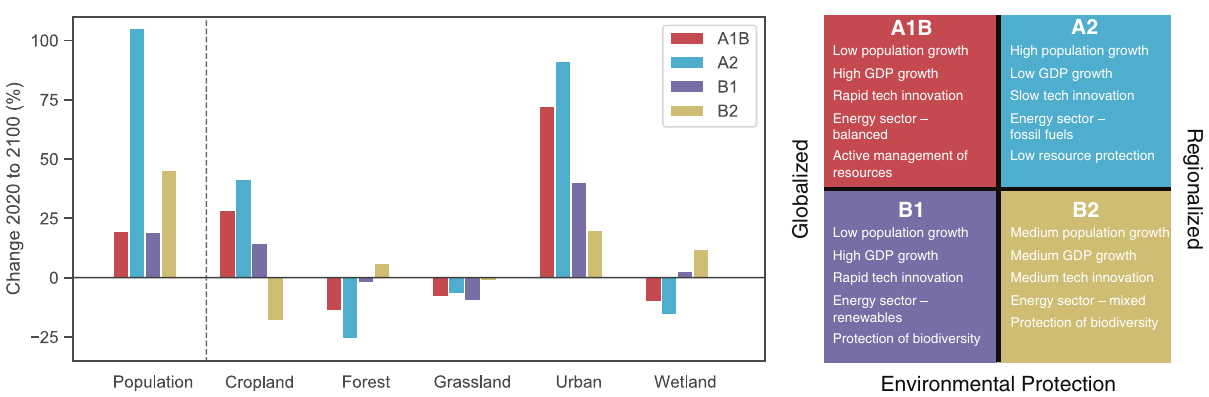
Fig. 1 Projected changes in national population and land cover between 2020 and 2100. Projections vary by IPCC SRES scenario, as indicated by the color of the bars. See EPA ICLUS (2008) for more information about population projections and Sohl et al. (2012) for more information about land cover projections.